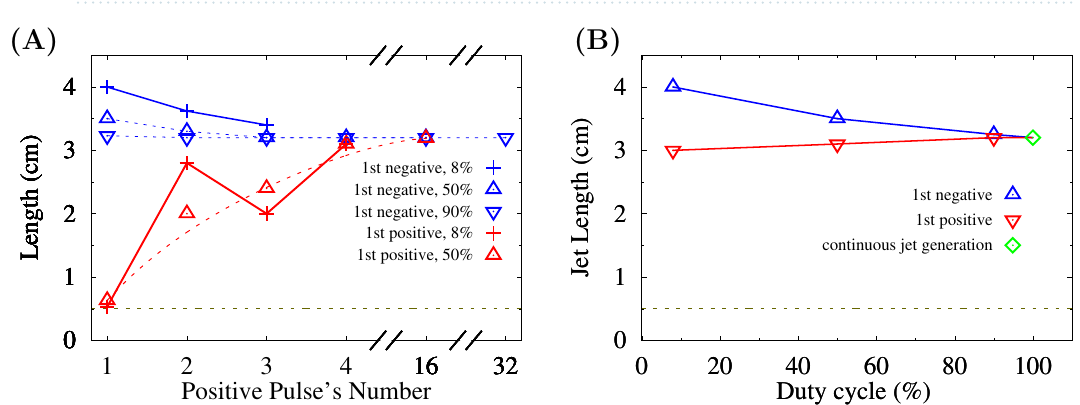
Figure 6. ( A ) The maximal length of the guided streamer versus the positive pulse number in a bunch for the first negative and first positive pulses. The 16th pulse is the last positive pulse for ≈ 50 % and the 32nd pulse is the last one for ≈ 90 %. ( B ) The maximal integral length of APPJ for different duty cylces. A point attributed to continius jet generation is from 32